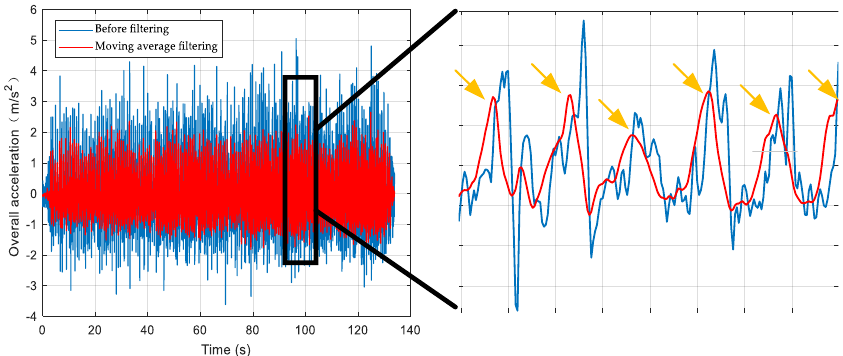
Figure 4. Acceleration signal preprocessing.